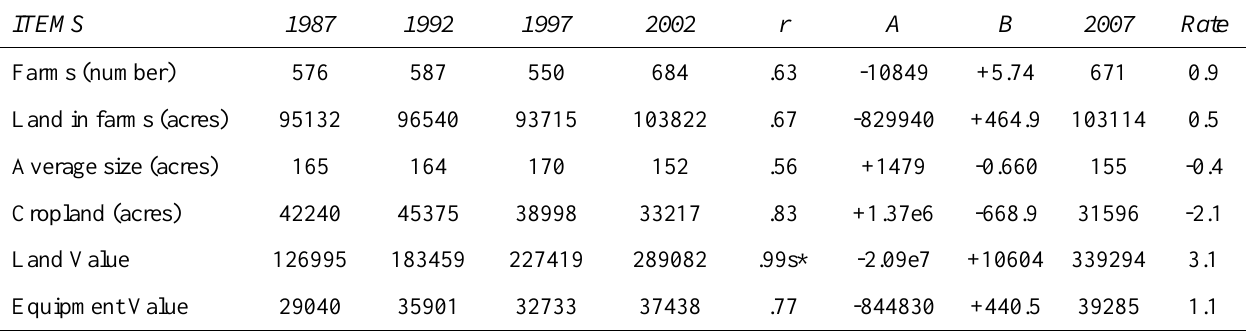
Table 2g: Simpson County Regression